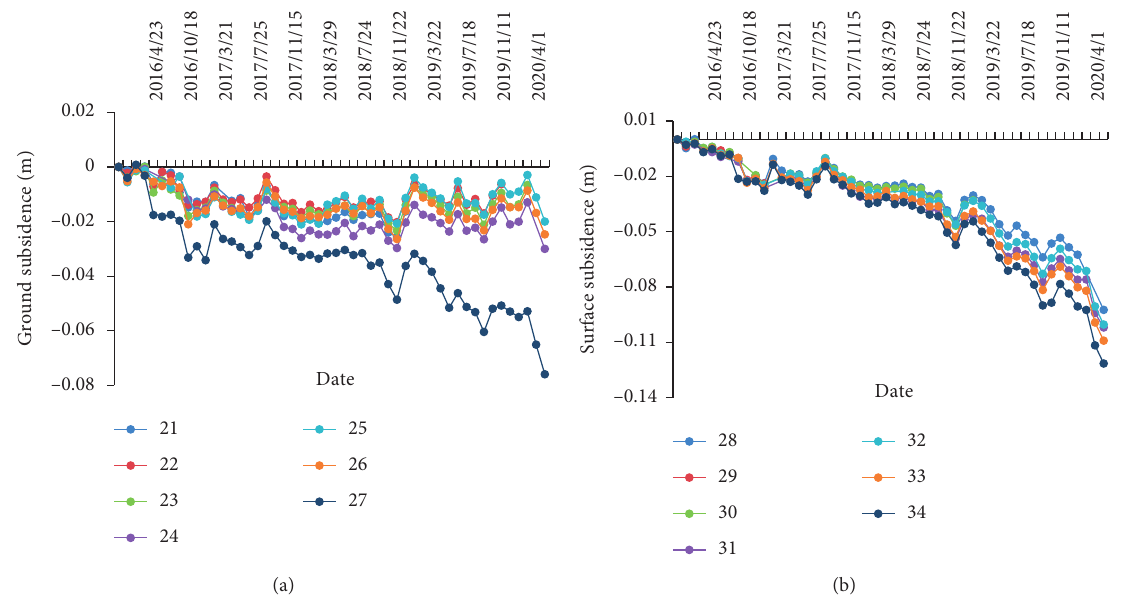
Figure 10: Surface observation of fault activation: (a) 21# ∼ 27# points and (b) 28# ∼ 34# points.